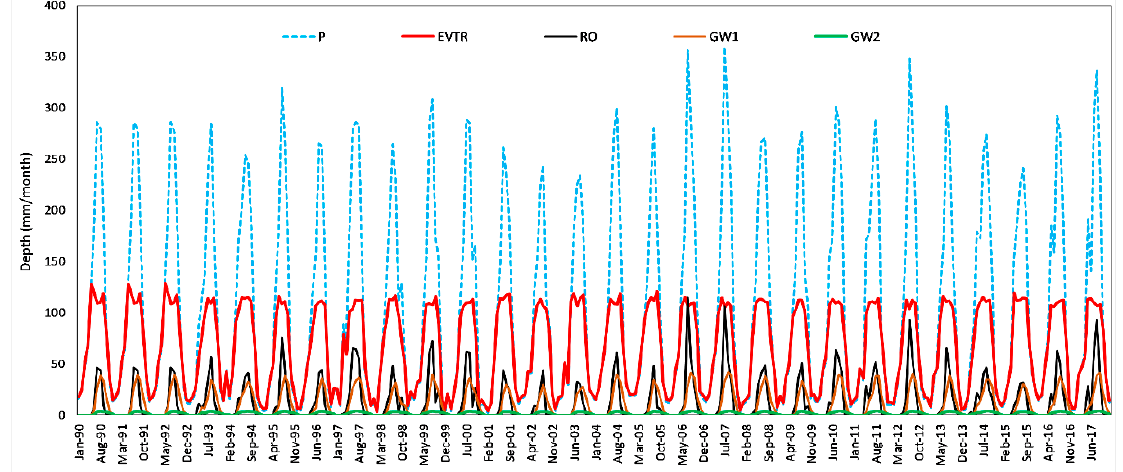
Figure 11. The monthly mass balance of the different processes on the basin scale (before transformation to hydrographs) during the period of study.